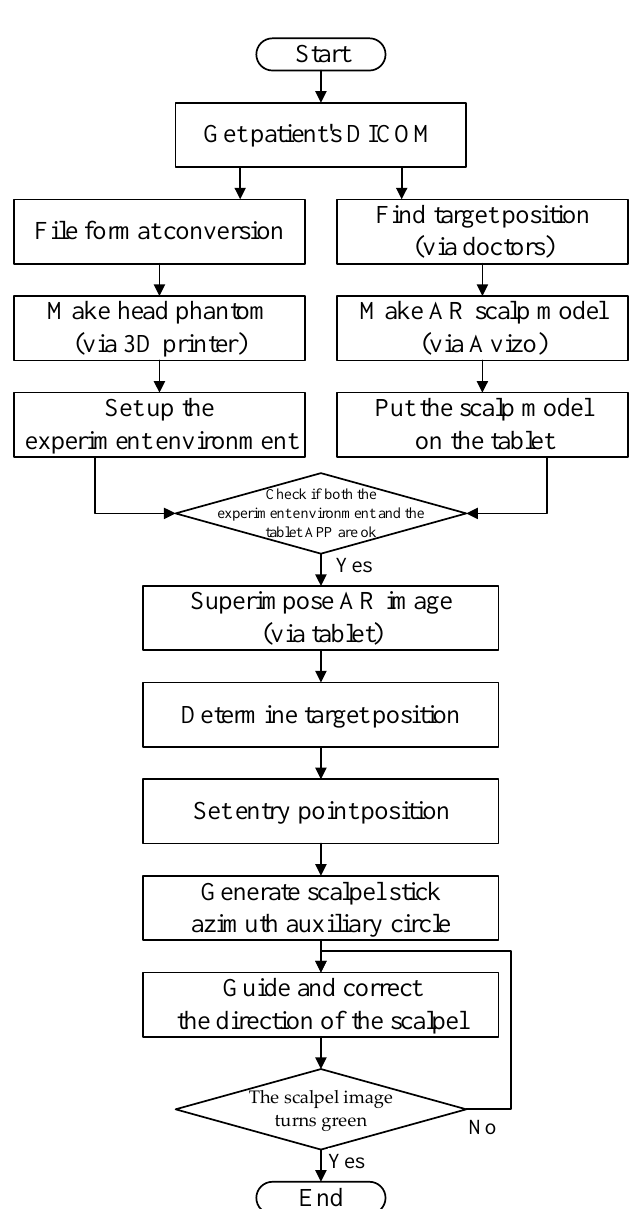
Figure 6. Laboratory simulation flow chart.